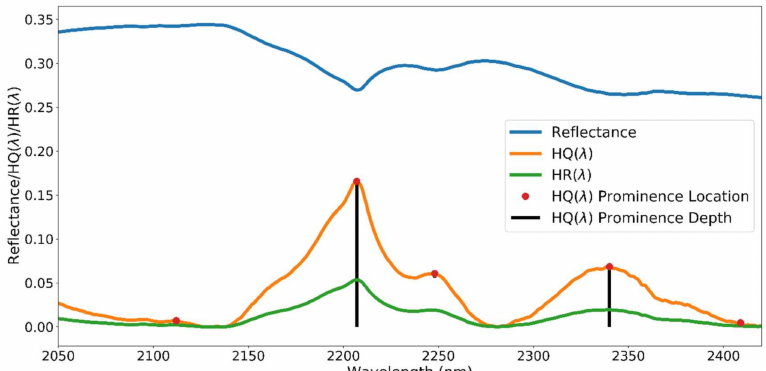
Figure 1. A reflectance spectrum (blue) and the corresponding hull quotient HQ D ( λ ) (orange) and HR D ( λ ) (green) after background removal. The location of 5 different features are shown located at the red markers and the depth of the two largest features shown by the black vertical lines. It is noted that for very small depths the vertical line is not